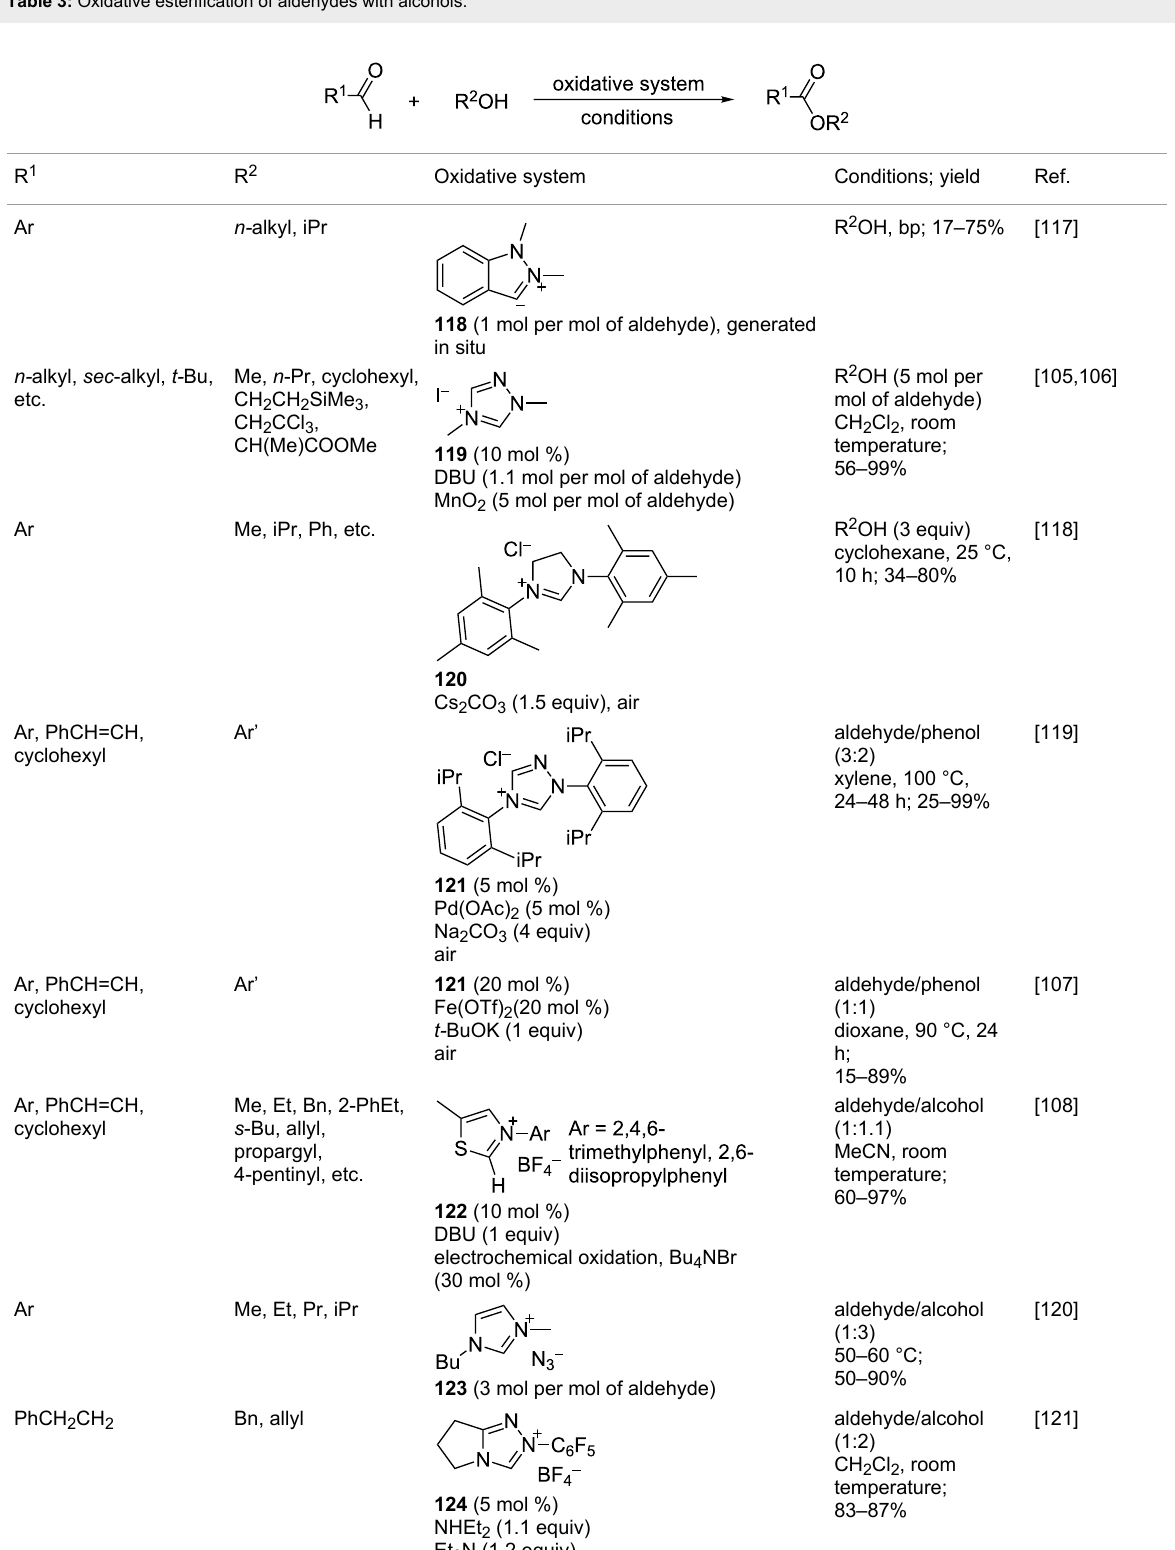
Table 3: Oxidative esterification of aldehydes with alcohols.